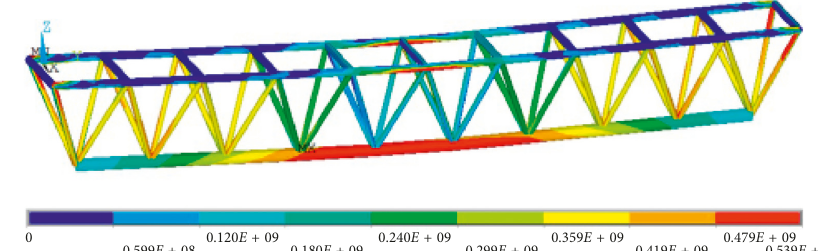
Figure 18: von Mises stress in the steel truss.